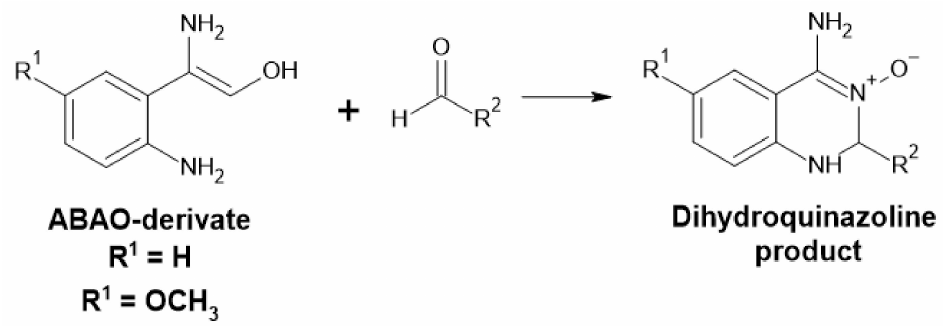
Figure 15. Detection of aldehyde by ABAO